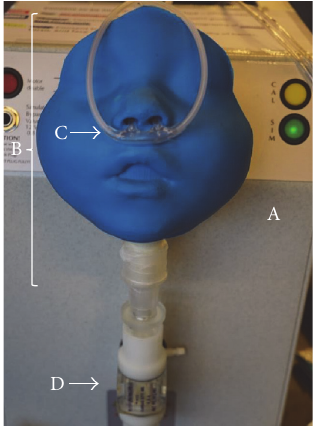
Figure 1: Equipment setup. (A) Test lung, (B) toddler airway model, (C) pediatric cannula, and (D) two-way